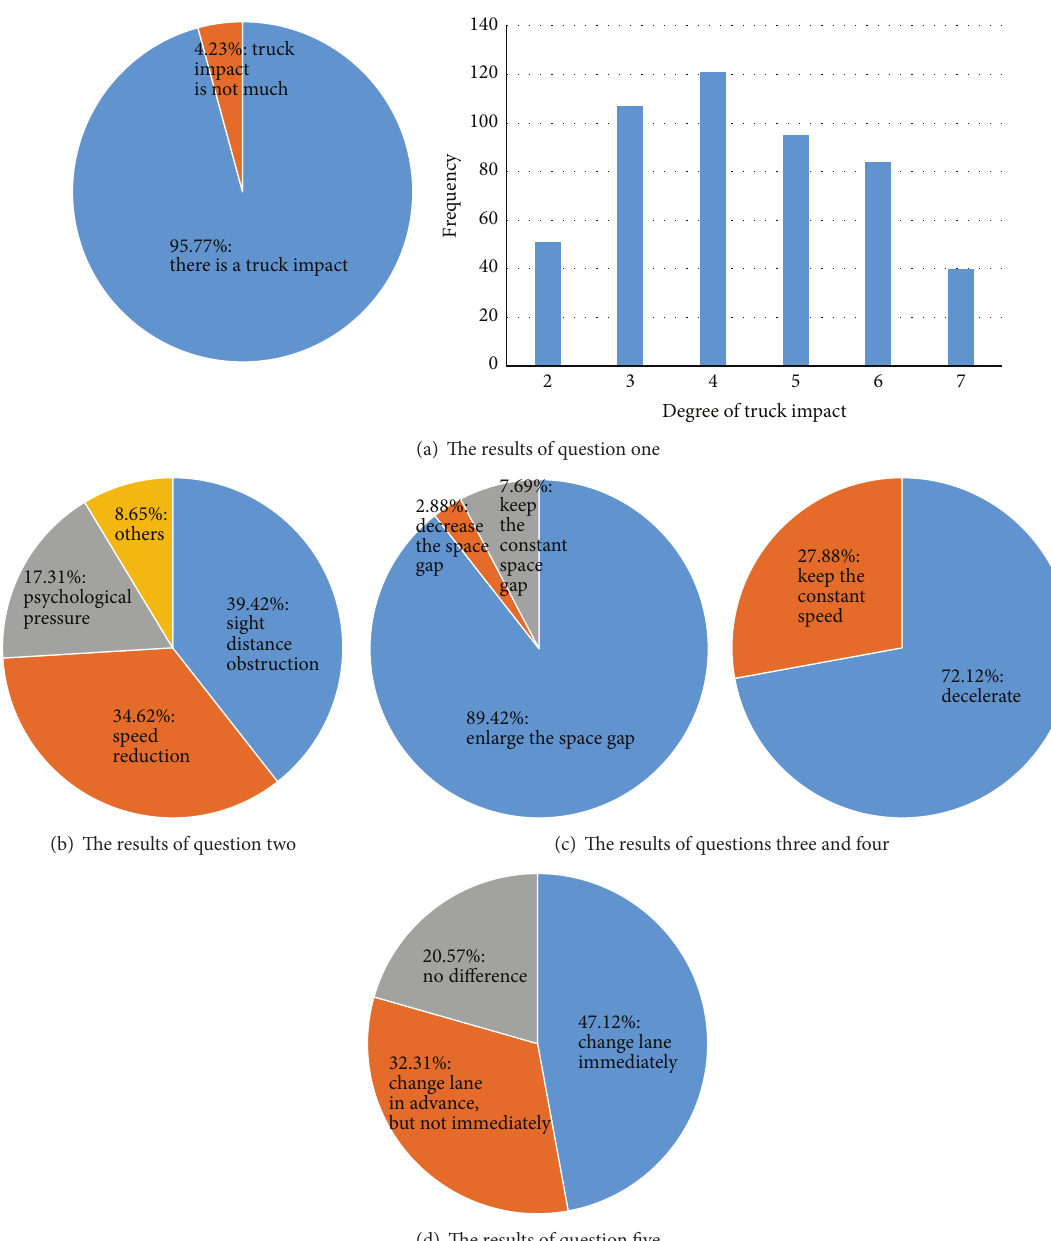
Figure 1: The results of the questionnaire